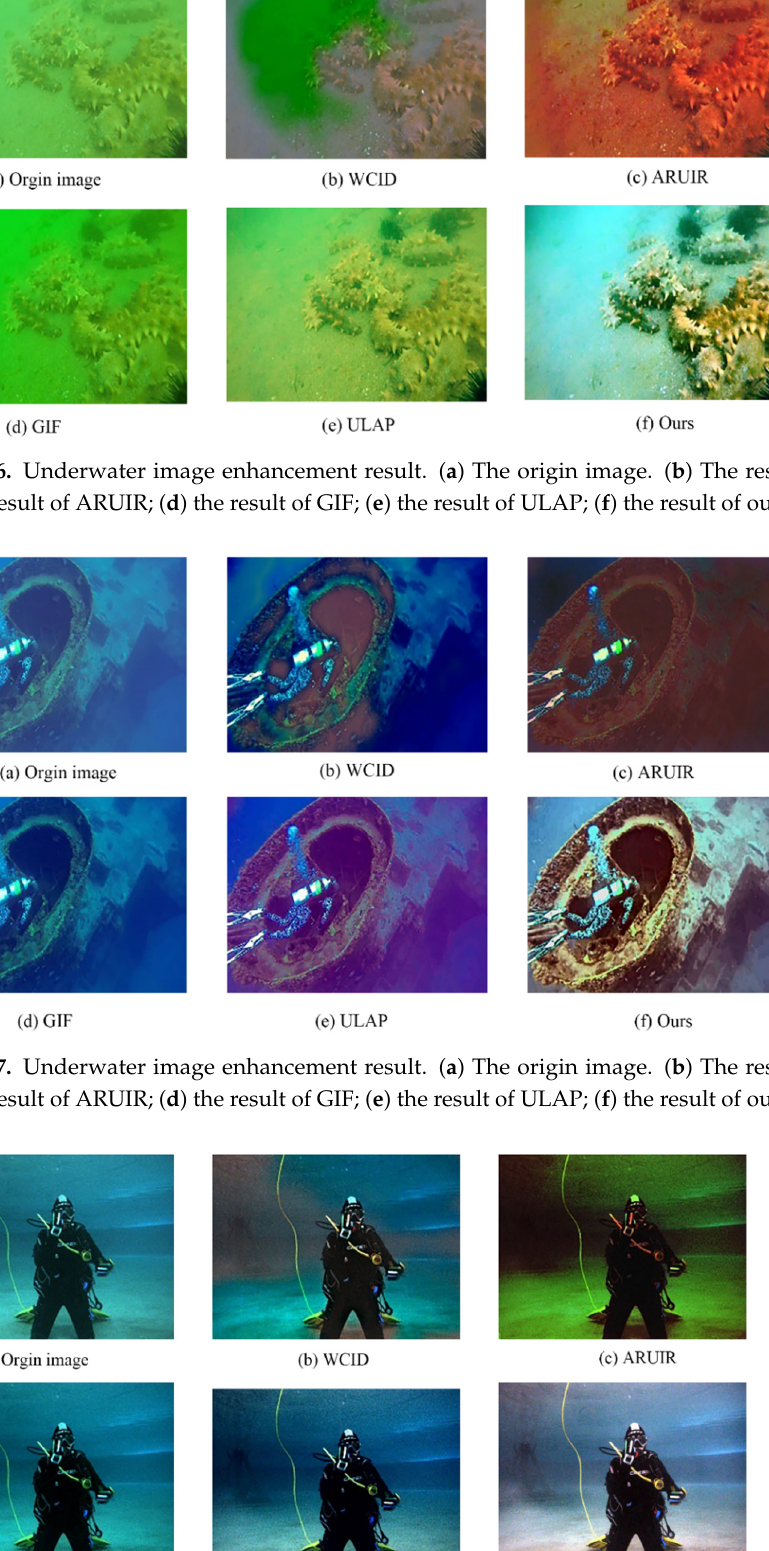
Figure 8. Underwater image enhancement result. ( a ) The origin image. ( b ) The result of WCID; ( c ) the result of ARUIR; ( d ) the result of GIF; ( e ) the result of ULAP; ( f ) the result of ours.